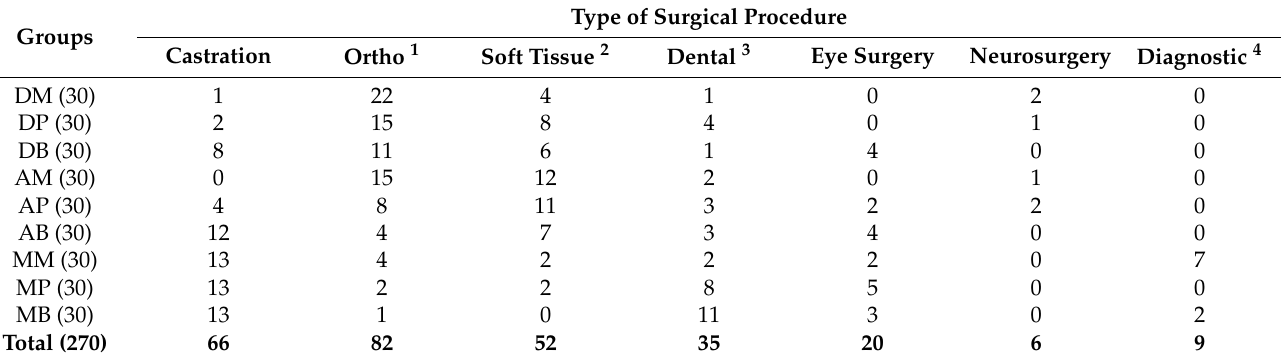
Table 5. The number of surgical procedures allocated to groups, in dogs submitted to esophageal pH-measurement during anesthesia for non-intrabdominal, non-intrathoracic procedures. (n = 30 dogs in each group, 270 dogs in total).